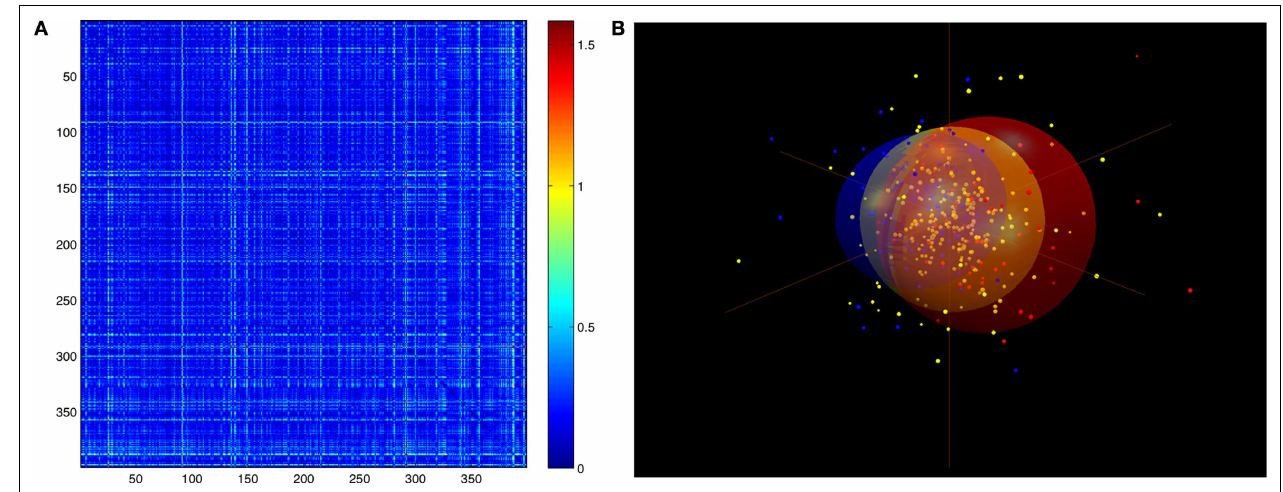
FIGURE 4 | (A) Visualization of the pair-wise distance matrix for N = 400 subjects of the ADNI dataset . (B) MDS projection of the dissimilarity matrix into 3D coordinates, each projection colored according to subject status, NC = blue, AD = red, MCI =